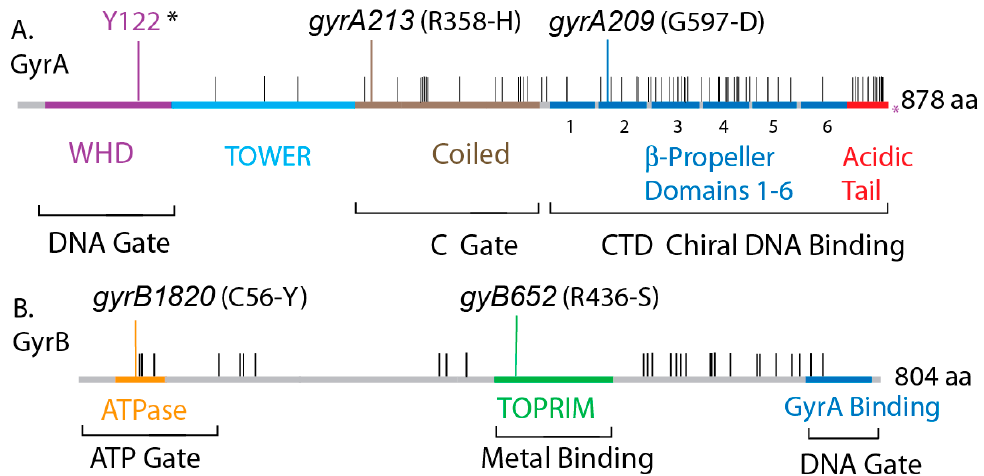
Figure 1. Conservation of protein sequences in E. coli and Salmonella gyrase and location of functional domains. ( A ) The GyrA protein is shown with the purple WHD domain, which contains the catalytic tyrosine (Y122*), the blue Tower domain, the brown coiled-coil domain that forms the C-gate, and the blue C-Terminal domain containing six pinwheel elements that fold into a spherical DNA binding surface. The red C-terminal acidic tail has many differences including the length of 38 residues in Salmonella compared to 35 in E. coli . ( B ) GyrB encodes the yellow ATPase domain that forms the ATP-gate, the green topoisomerase-primase (TOPRIM) domain that coordinates Mg++ binding, and a C-terminal GyrA interaction domain. Positions in GyrA and GyrB that encode different amino acids are shown as black hatches along the Salmonella map.